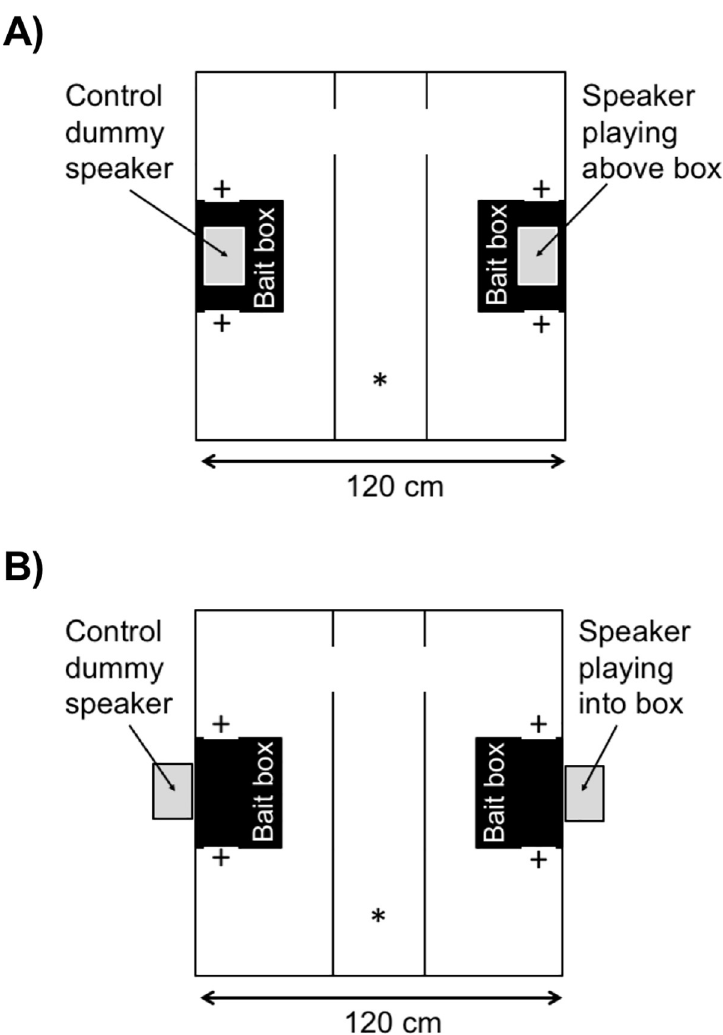
Fig 1. Design of laboratory test arena. A) Speaker placed 50 cm above the bait box. B) Speaker placed outside arena to play through the bait box. � Position of subject placement into arena via handling tunnel; + bait box